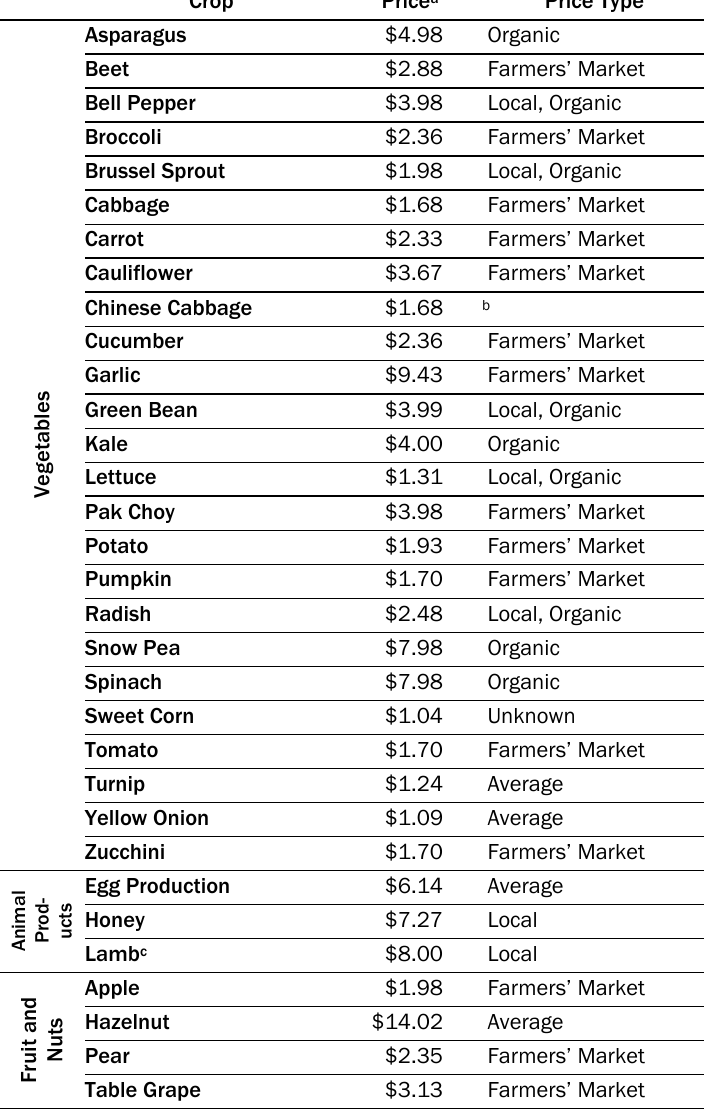
Table 2. Crop Prices Used in Calculation of Economic Potential of Underutilized Agricultural Land Reserve Lands in Surrey,